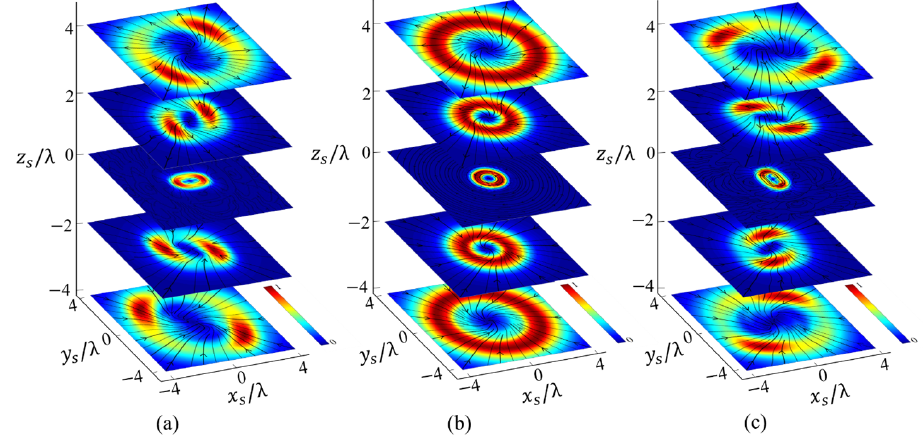
( a ) σ c = 0.5; ( b ) σ c = 1;